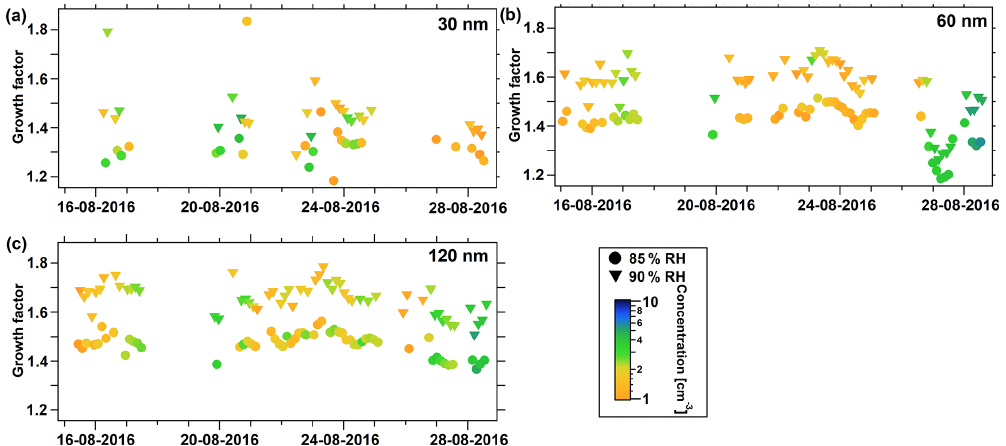
Figure 8. Particle hygroscopic growth factors during the summer study. (a) Growth factor at 30nm Dp dry , (b) at 60nm Dp dry , and (c) at 120nm Dp dry . Dots represent values at 85% RH and triangles at 90% RH. The color indicates the raw particle number concentration measured at that certain Dp dry , downstream of the first and upstream of the second